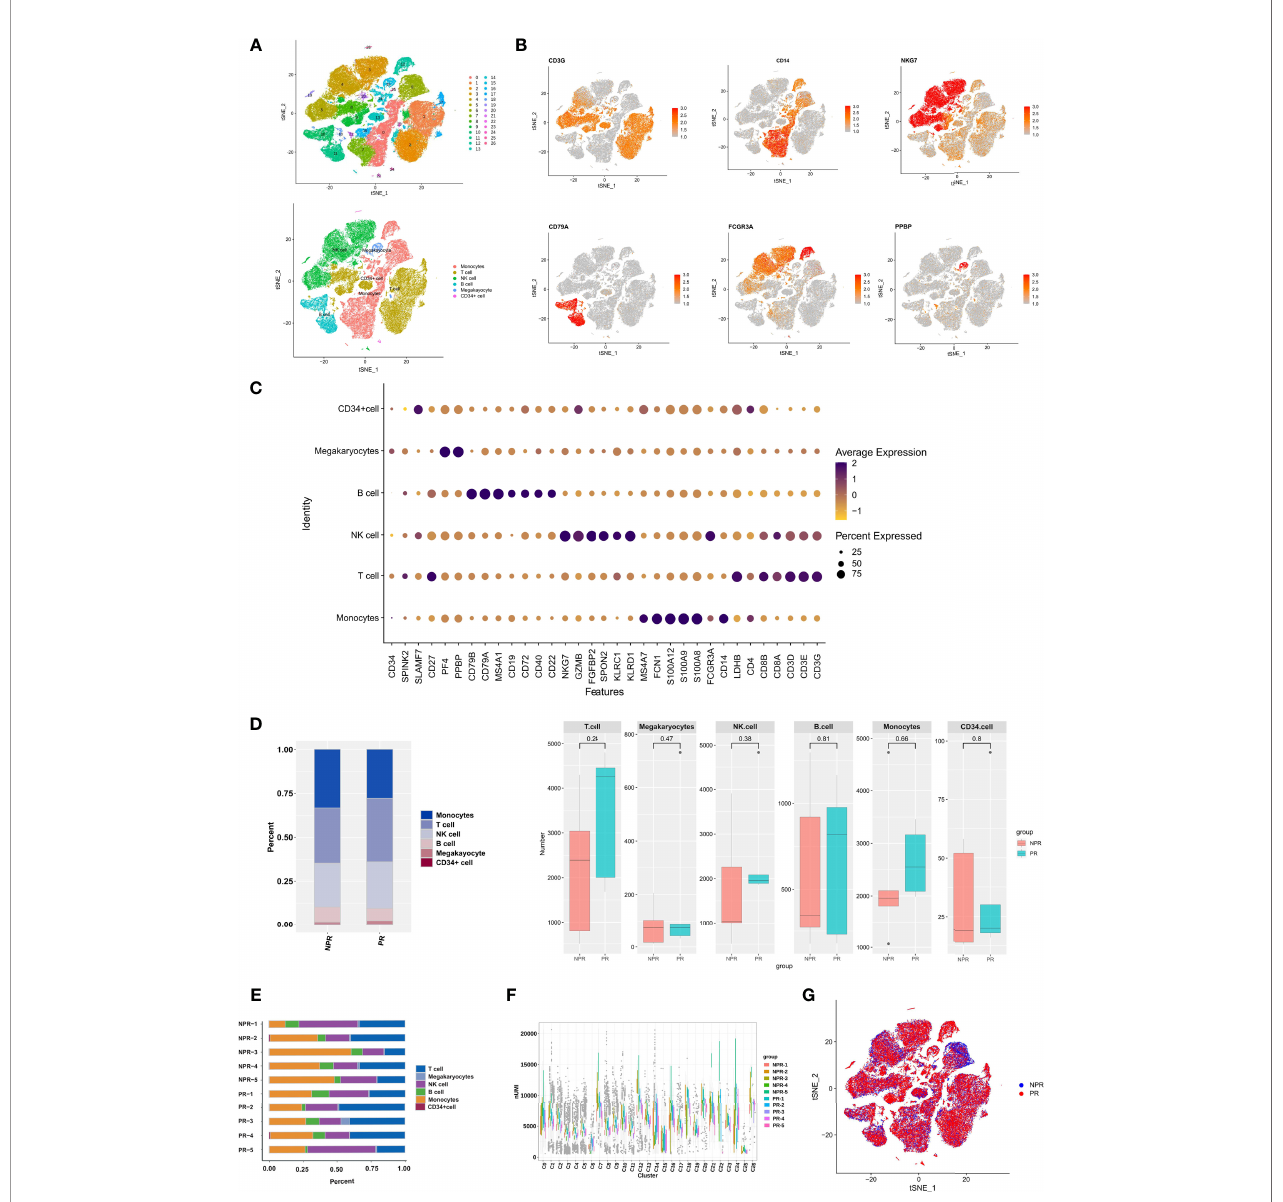
FIGURE 1 | Circulating immune cell landscape in patients with and without PR. (A) t-SNE plot presenting clustering of total PBMCs reveals 27 clusters and 6 cell types. (B) t-SNE plot of marker genes of each cell type. (C) Dot plot showing the top marker genes revealed by single-cell RNA sequencing of cell types de fi ned in (A) . (D) Percentage of cell types and the comparison of cell number in each cell type between PR and NPR. (E) Cell proportion of each patient. (F) UMI number of each cluster. (G) t-SNE plot of patients with PR and